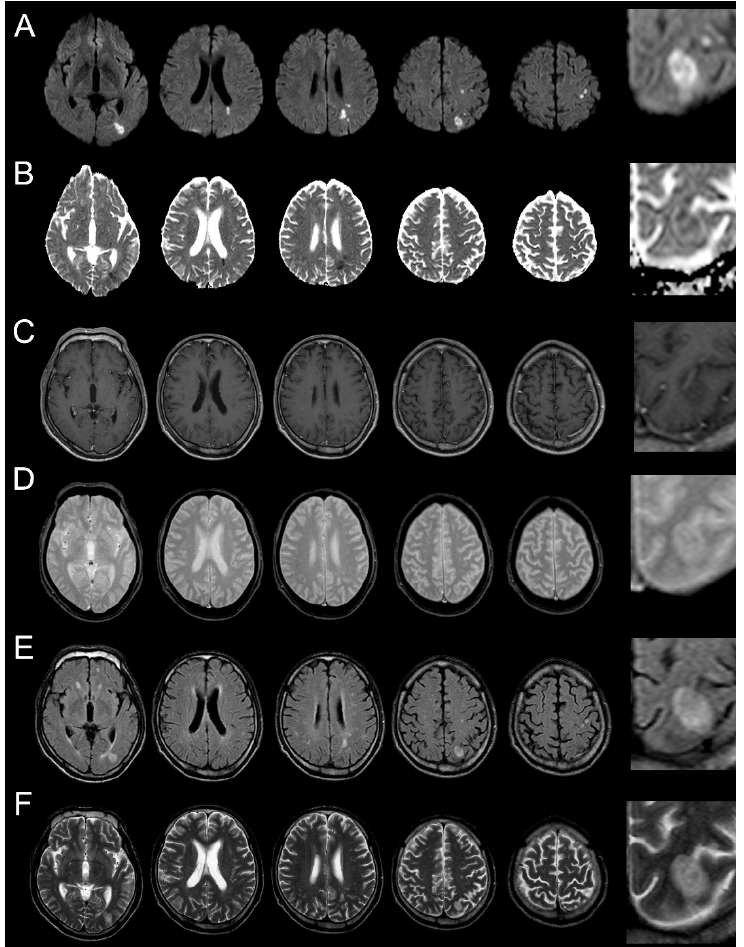
Figure 1. Brain MRI was performed 2 days after symptom onset. ( A ): diffusion-weighted magnetic resonance imaging (MRI); ( B ): apparent diffusion coefficient map (ADC); ( C ): contrast enhanced T1- weighted MRI; ( D ): T2 *-weighted MRI; ( E ): fluid-attenuated inversion recovery (FLAIR); ( F ): T2- weighted MRI). Multiple lesions can be seen in the border area between the middle cerebral artery and posterior cerebral artery in the left hemisphere. High signal intensity lesions on diffusion- weighted MRI and their corresponding low-signal lesions on the ADC, without enhancement on contrast-enhanced T1-weighted MRI and without low signal on T2 *-weighted MRI, are seen. T2- weighted MRI shows a high signal lesion with subtle low signal in the center of the ovoid-shaped dominant peripheral lesion. Figures in the right column are magnified regions of interest from the images of the lesion marked (*).